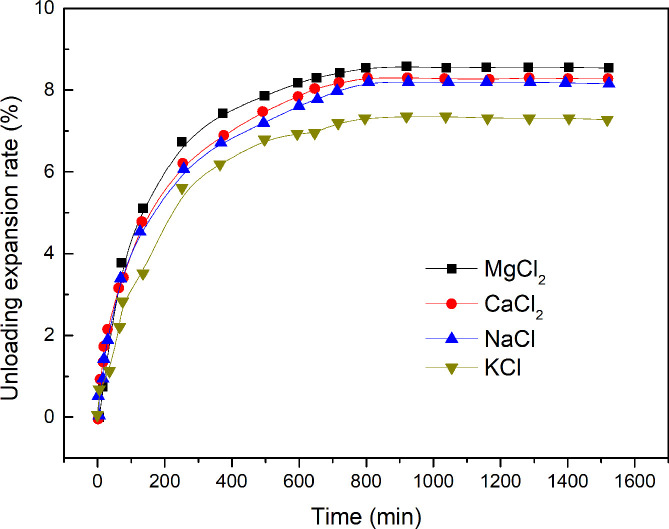
Time-dependent unloading expansion rate of expansive soils containing different types of ions.